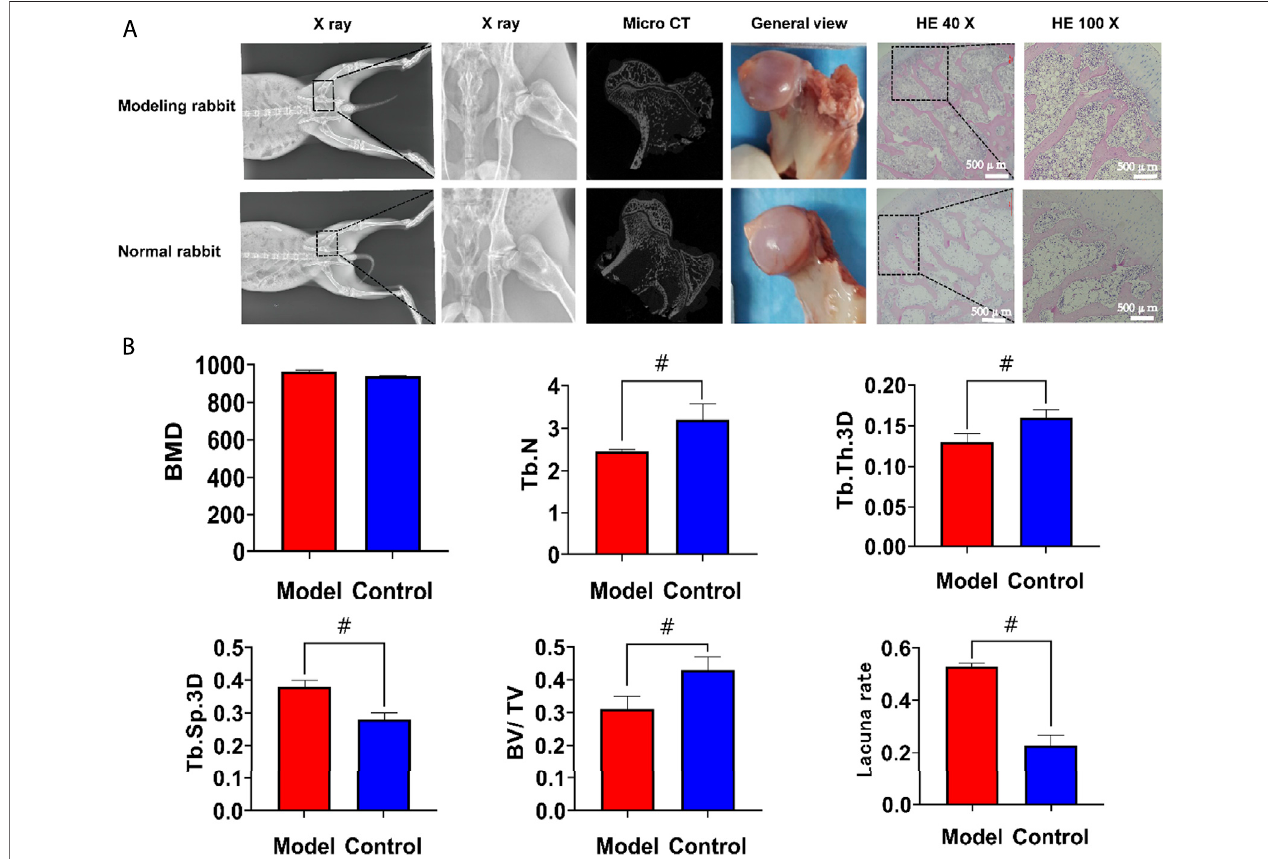
FIGURE 7 | The results of modeling of the steroid-induced osteonecrosis model in New Zealand rabbits. (A) After modeling, there was no collapse of the femoral head. Compared with the normal rabbits, the X-ray, Micro CT and HE staining showed that the trabeculae in the femoral head became thinner and the empty lacunae increased (B). Statisticalresultsofregionsofinterest.Thenumberoftrabeculaeandthebonevolume/tissuevolumewassigni fi cantlylowerthanthatinthenormalgroup, the trabecular space was higher than the normal group but there was no signi fi cant difference in the mineral density between the two groups. The empty bone lacuna rate in the model group was more than 50%, which was signi fi cantly higher than that in the control group. HE, hematoxylin-eosin staining; BMD, bone mineral density; Tb. N, number of trabeculae; Tb. Th.3D, trabecular thickness; Tb. Sp.3D, trabecular space; BV/TV, bone volume/tissue volume. VEGF, vascular endothelial growth factor; BMP2, Bone Morphogenetic Protein 2; ALP, alkaline phosphatase. #, p ＜ 0.05.